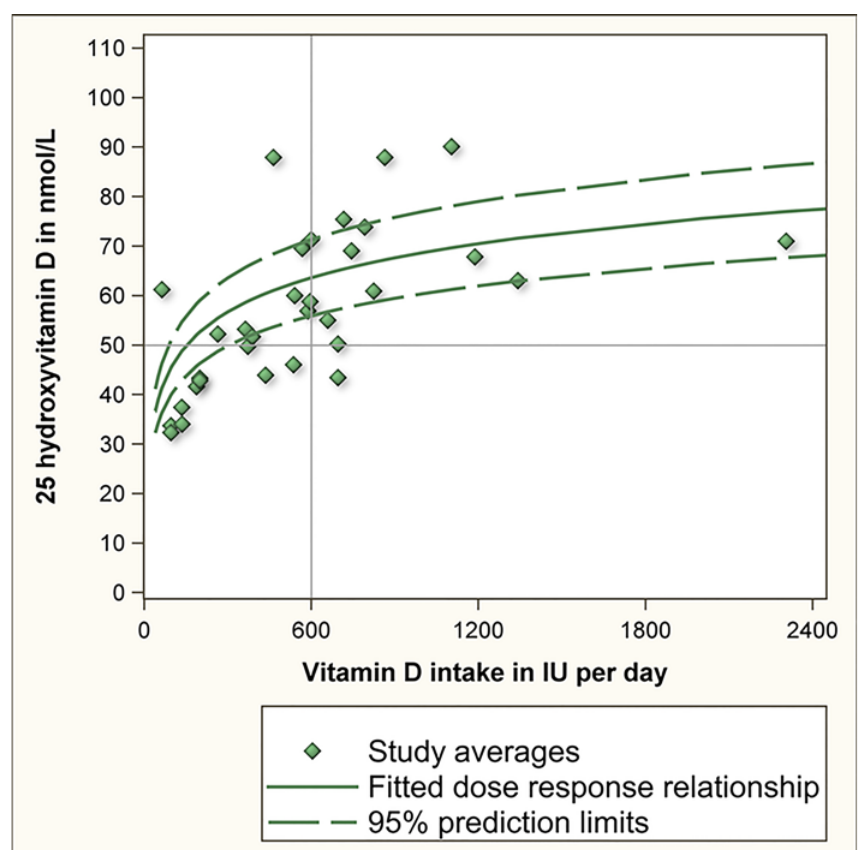
Figure 1. Dose response relationship of vitamin D intake and serum 25 hydroxyvitamin